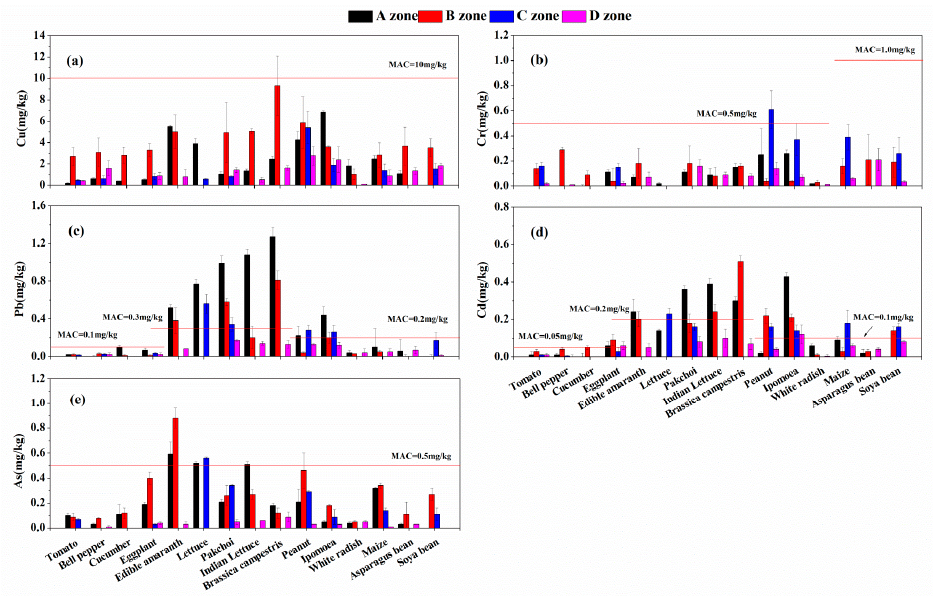
Figure 4. Heavy metals in edible parts of vegetable and crop species in the four zones: ( a ) Cu; ( b ) Cr; ( c ) Pb; ( d ) Cd; ( e ) As.